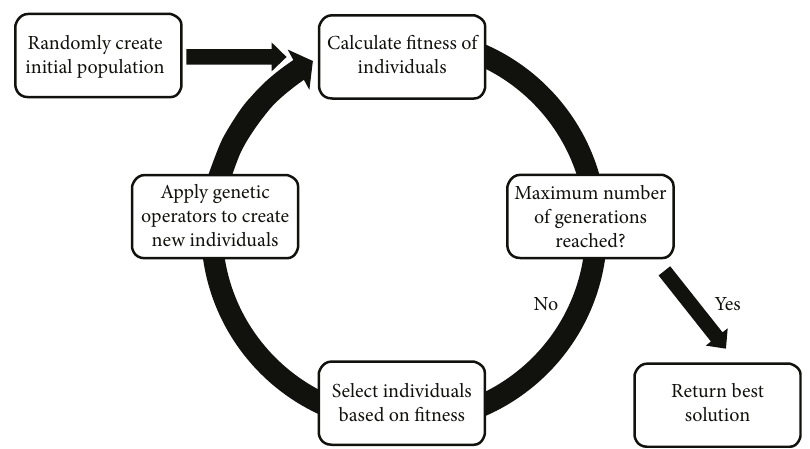
Figure 1: Typical work fl ow of a